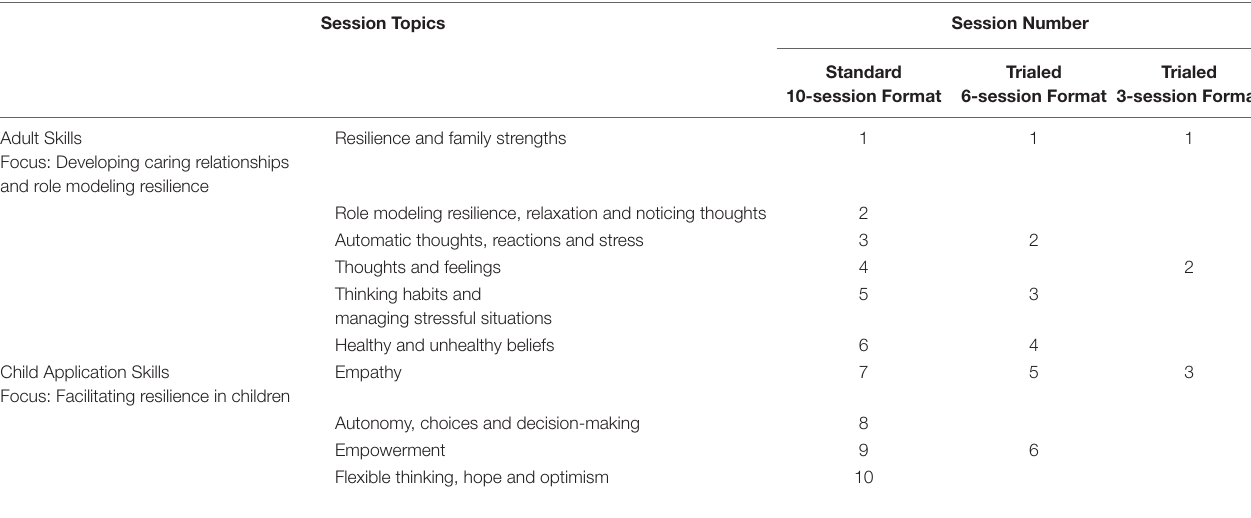
TABLE 1 | BBT sessions, objectives, and